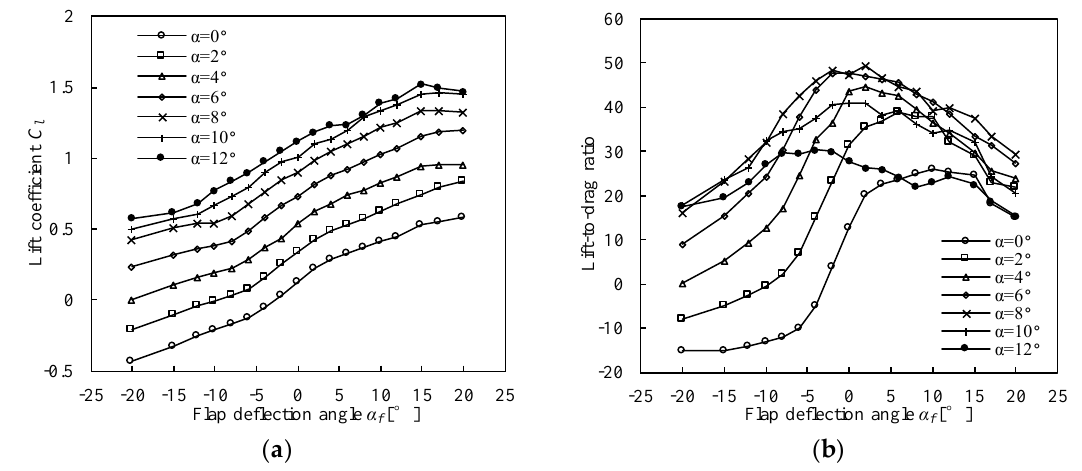
Figure 4. Aerodynamic performance of the airfoil NACA 64-218 with a trailing-edge flap. ( a ) Lift coefficient; ( b ) Lift-to-drag ratio.